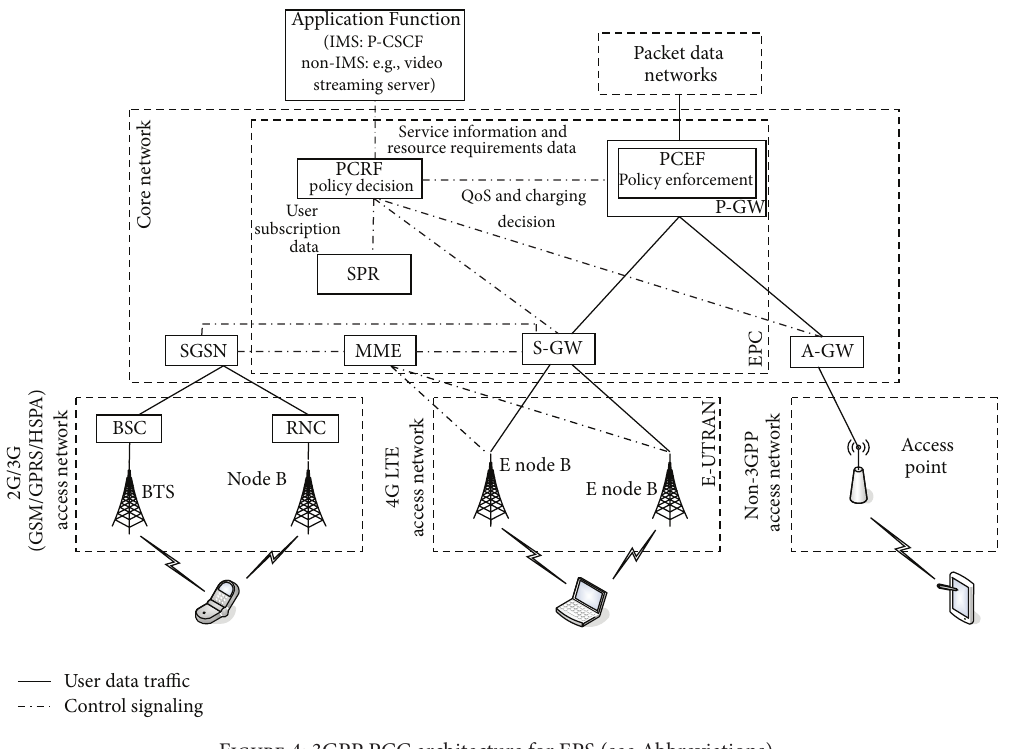
Figure 4: 3GPP PCC architecture for EPS (see Abbreviations).